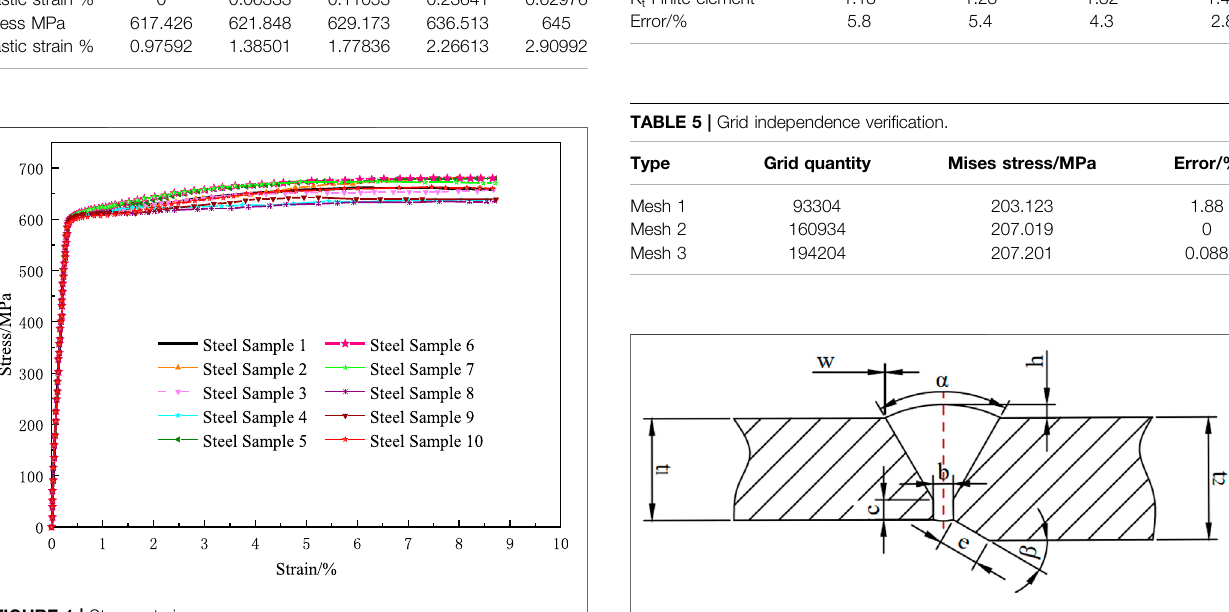
FIGURE 1 | Stress – strain curve.